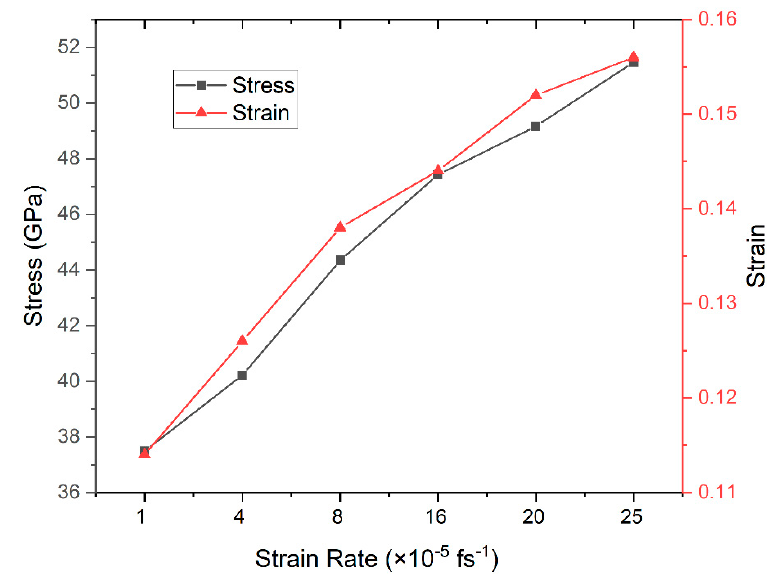
Figure 8. Variation law of ultimate stress and ultimate strain of PGO under different strain rates.